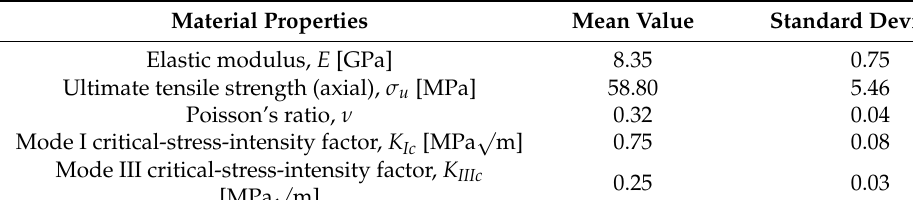
Table 1. Mechanical properties of the spruce wood tested.